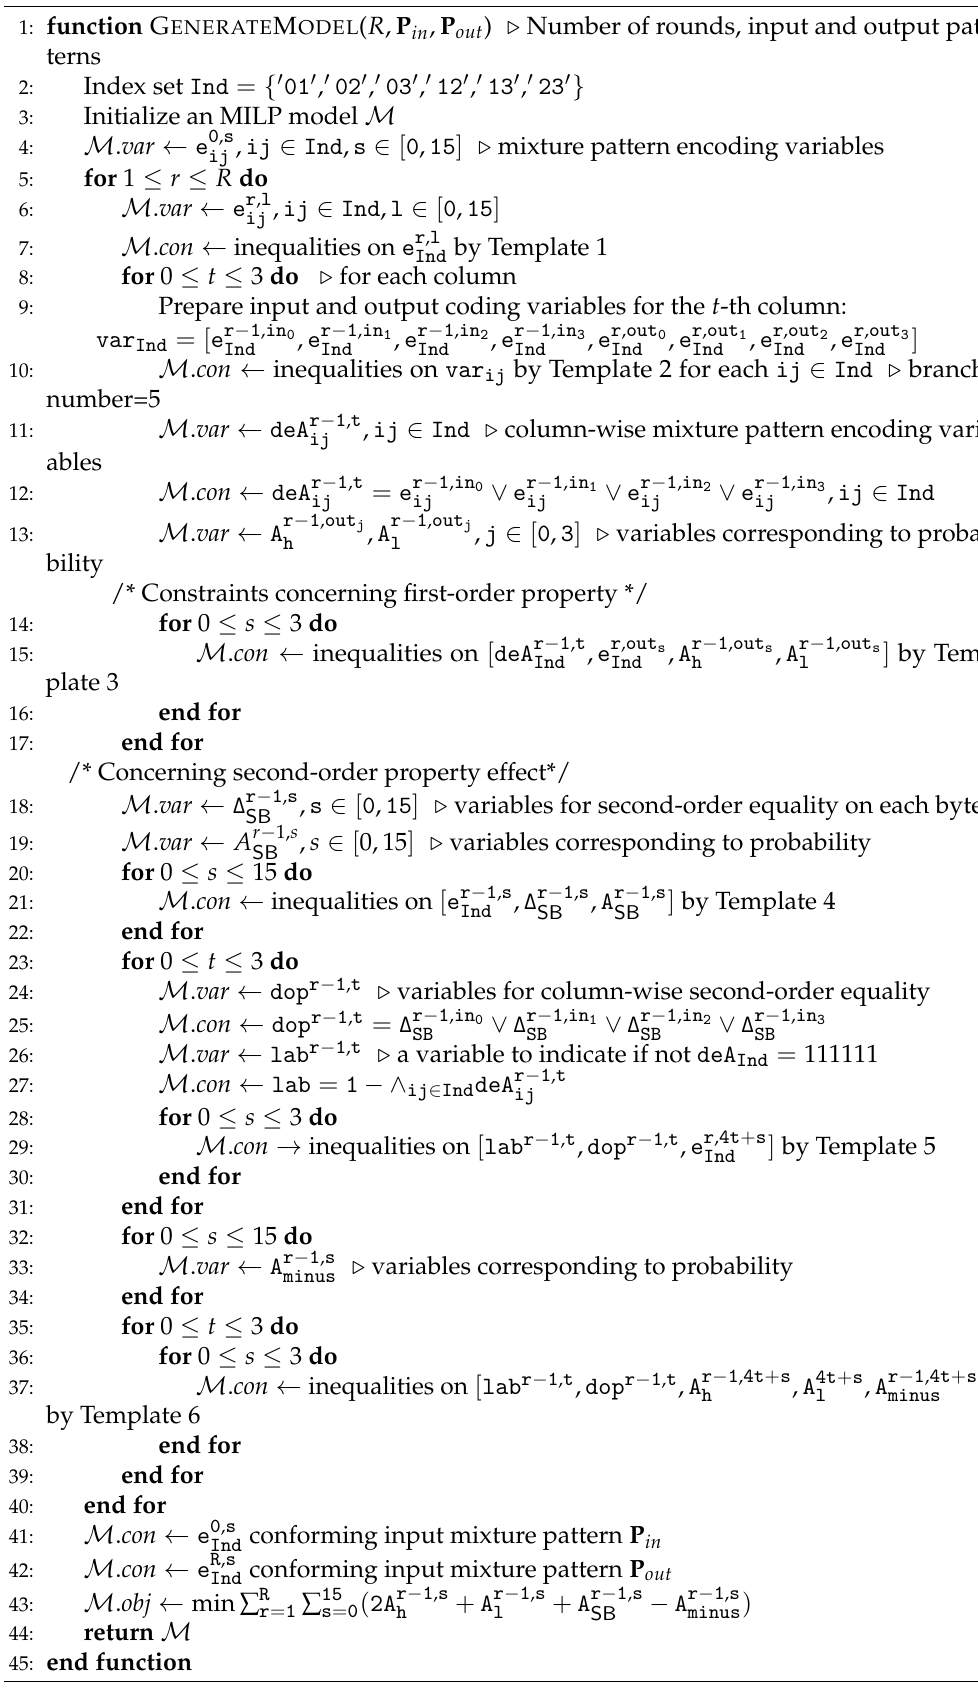
Algorithm 1 MILP model to get the probability of given mixture